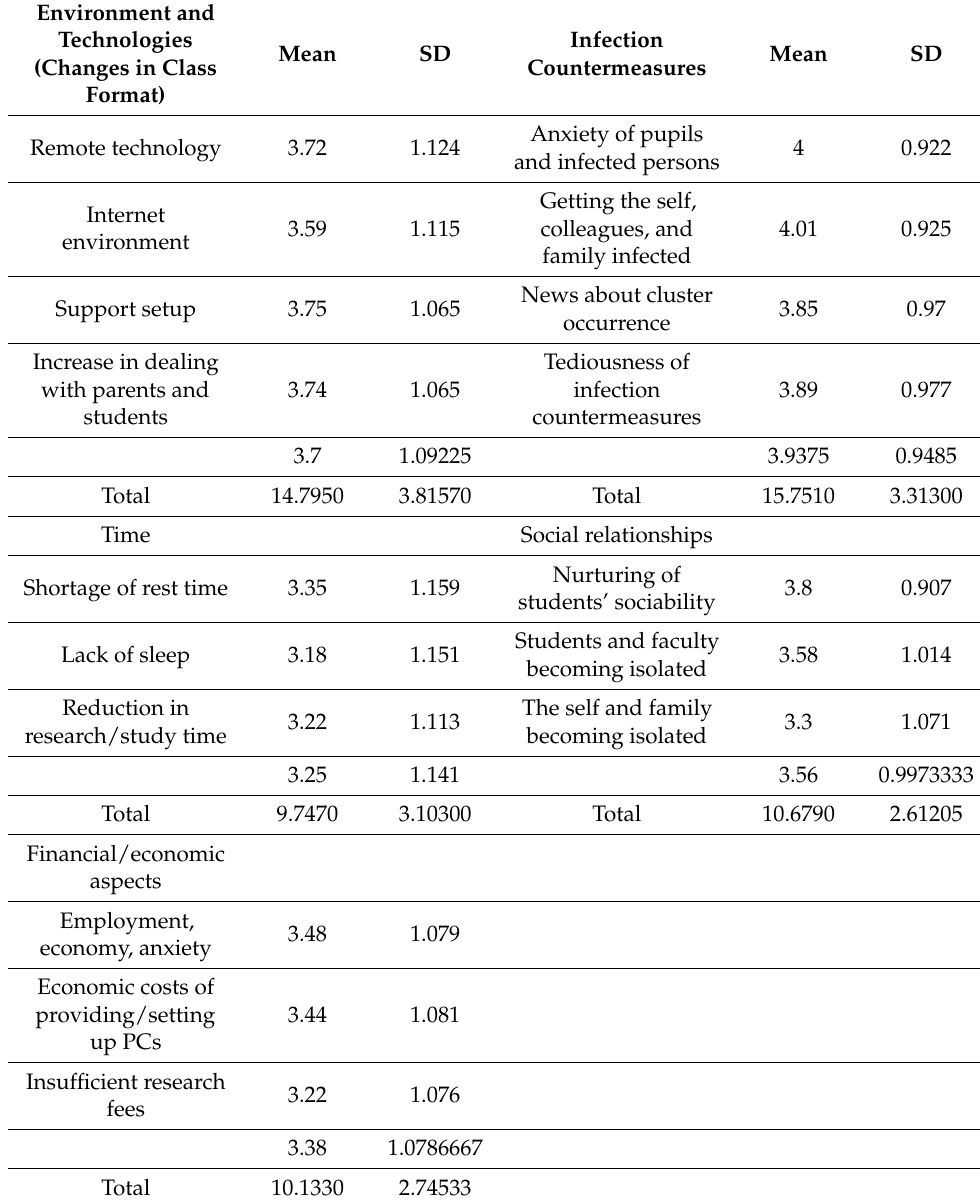
Table 5. Burden/anxiety at educational sites due to